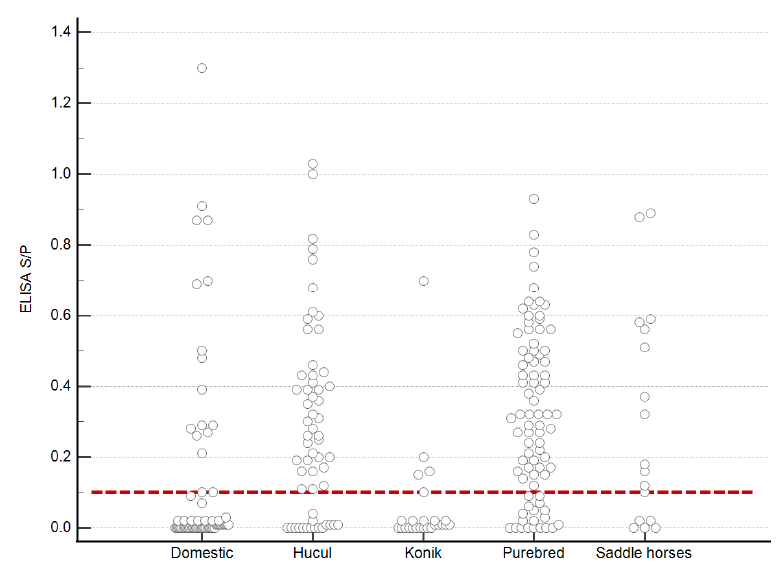
Figure 5. Distribution of EFVeca Gag reactivity in serum samples from different horse breeds. Each grey circle represents the S/P of an individual serum, dashed red line indicates the cut-off value of ELISA (S/P > 0.1). Commas were used as decimal points due to software settings.